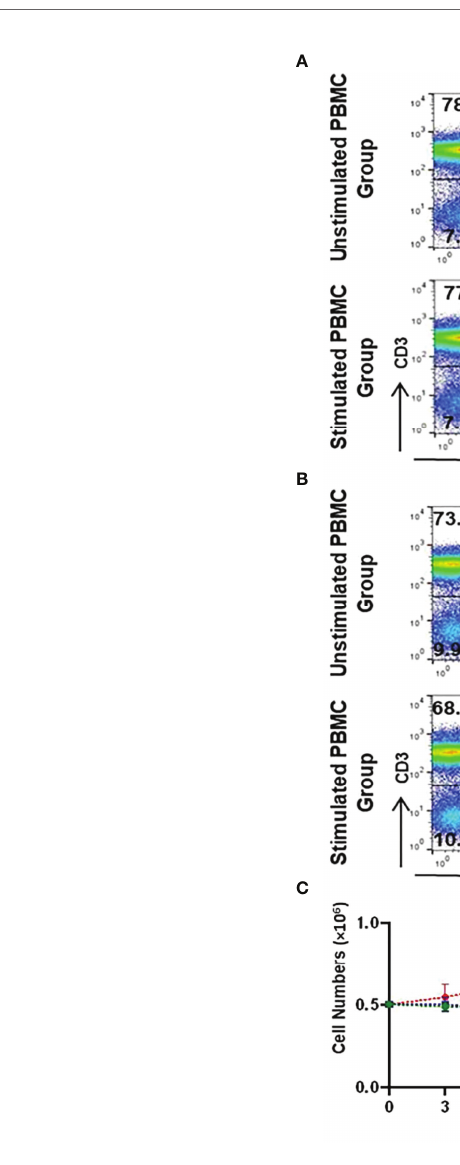
FIGURE 2 | Representative gating strategy for identifying Un/S CD3 - CD56 + NK cells and their expression of CD94 and CD69 as well as the persistence of NK cells. (A) CD94 and (B) CD69 gating strategies involved the identi fi cation of lymphocytes based on FSC vs. SSC, followed by dead cell exclusion. Within the CD3 - CD56 + NK cell populations, fl ow cytometry plots show receptor expression relative to their counterparts incubated with the respective isotype-matched control mAb. (C) The persistence of unstimulated (Un) NK and stimulated (S) NK cells with either TKD/IL-2 or IL-2/IL-15 were compared in a parallel culture. After seeding (5x10 5 cells/well), cell proliferation was determined based on viable cell counts at three-day intervals up to 15 days. Day zero of the experiment was started on the fi rst day after removing the beads and adding to the well. Data are shown as the mean of n ≥ 3 independent donors ±